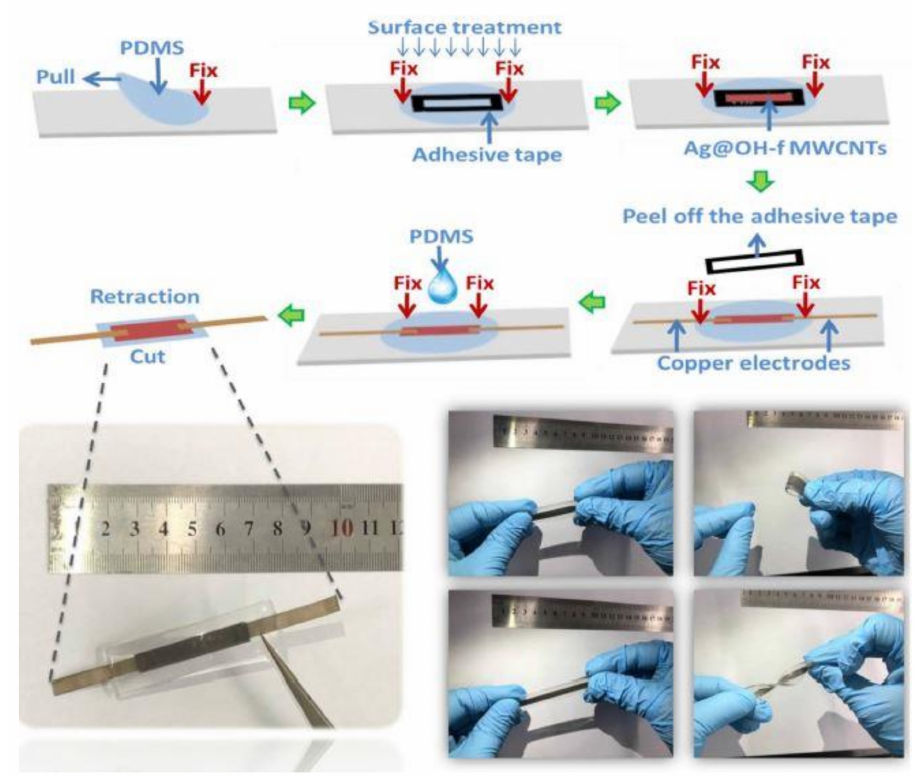
Figure 7. Flow of the fabrication process of the Ag NP/MWCNT-based strain sensors [113]. Repro- duced from Yuan, Z.; Pei, Z.; Shahbaz, M.; Zhang, Q.; Zhuo, K.; Zhao, C.; Zhang, W.; Ma, X.; Sang,